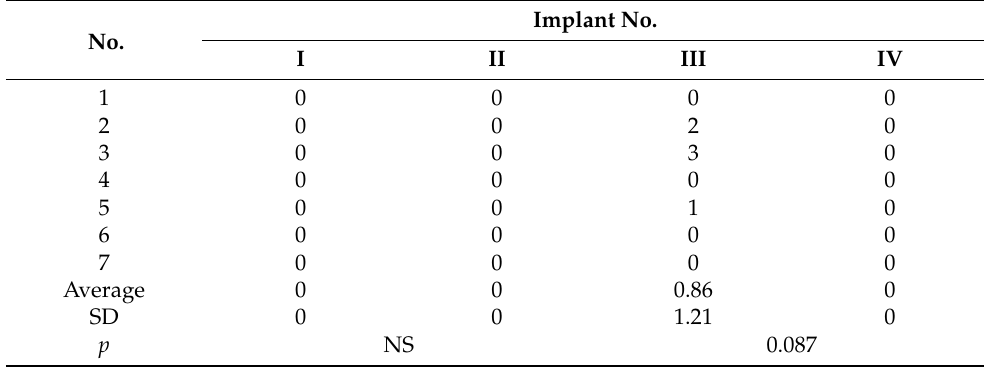
Table 3. Buccal EMBL at stage-II surgery